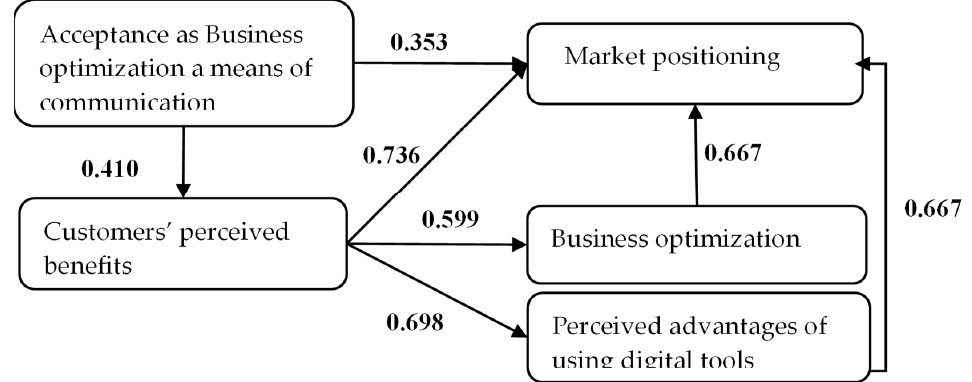
Figure 2. Adoption model proposed in this study, along with variables and correlational loadings (Cramér’s V)